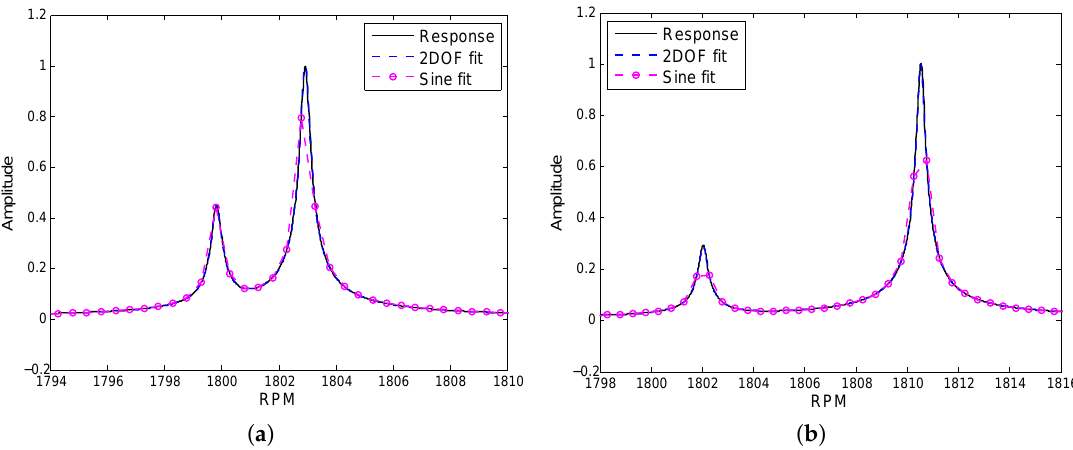
Figure 8. Comparison of non-dimensional amplitudes obtained by different fitting methods for EO = 6 and ζ 1,2 = 0.0001, ( a ) SD = 0.05, ( b ) SD =